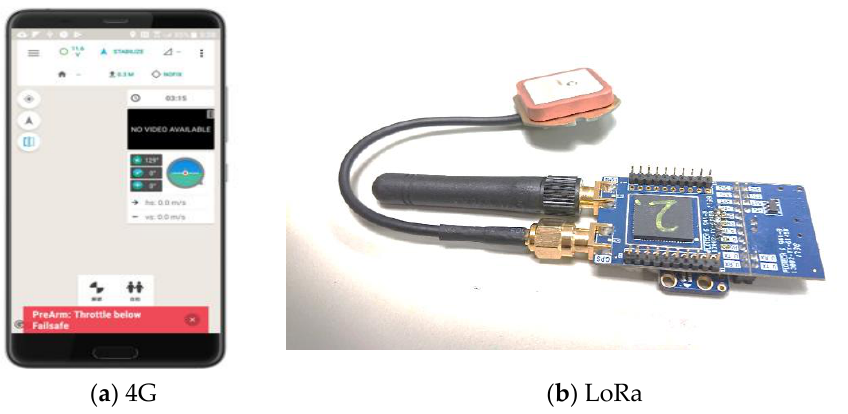
Figure 4. Automatic dependent surveillance–broadcast (ADS-B) like on-board units (OBUs) for the 4th generation mobile communi cation long term evolution (4G/LTE) and LoRa.